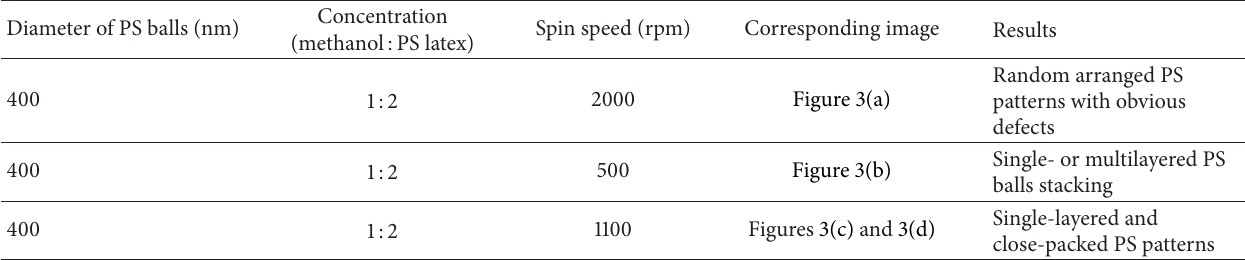
Table 2: The distribution results for the self-assembled PS nanosphere patterns at different spin speed conditions. Diameter of PS balls (nm)